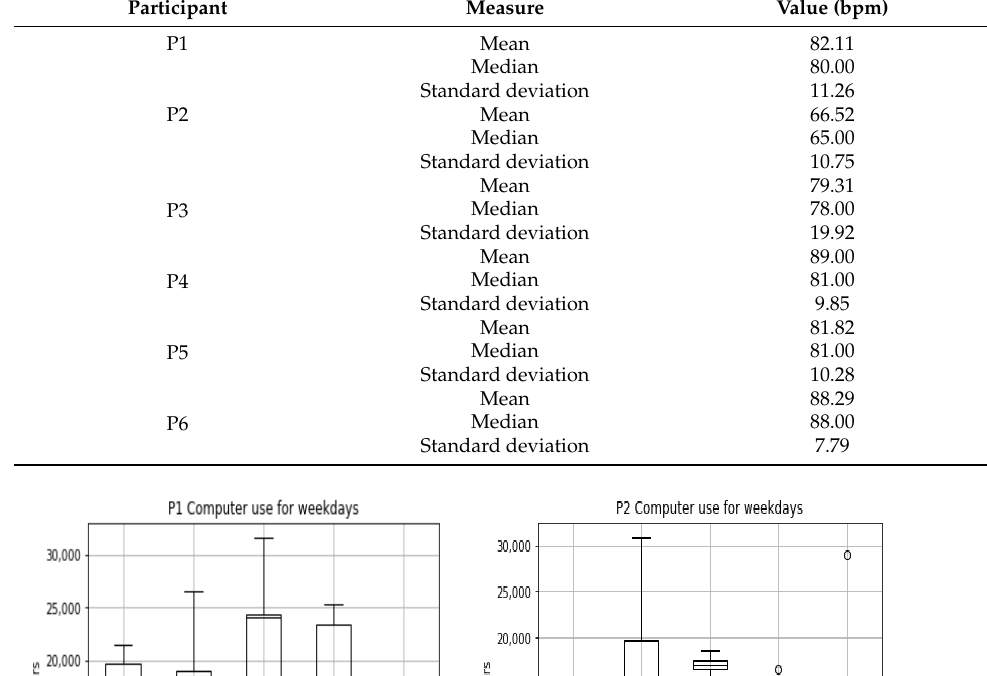
Table 2. Heartrate Summary ( n = 6).